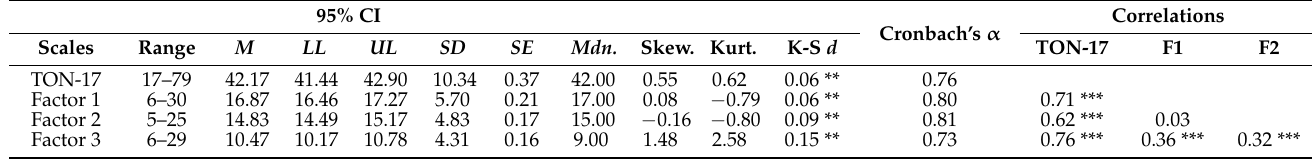
Table 4. Descriptive statistics for the TON-17 (Sample 3, n =